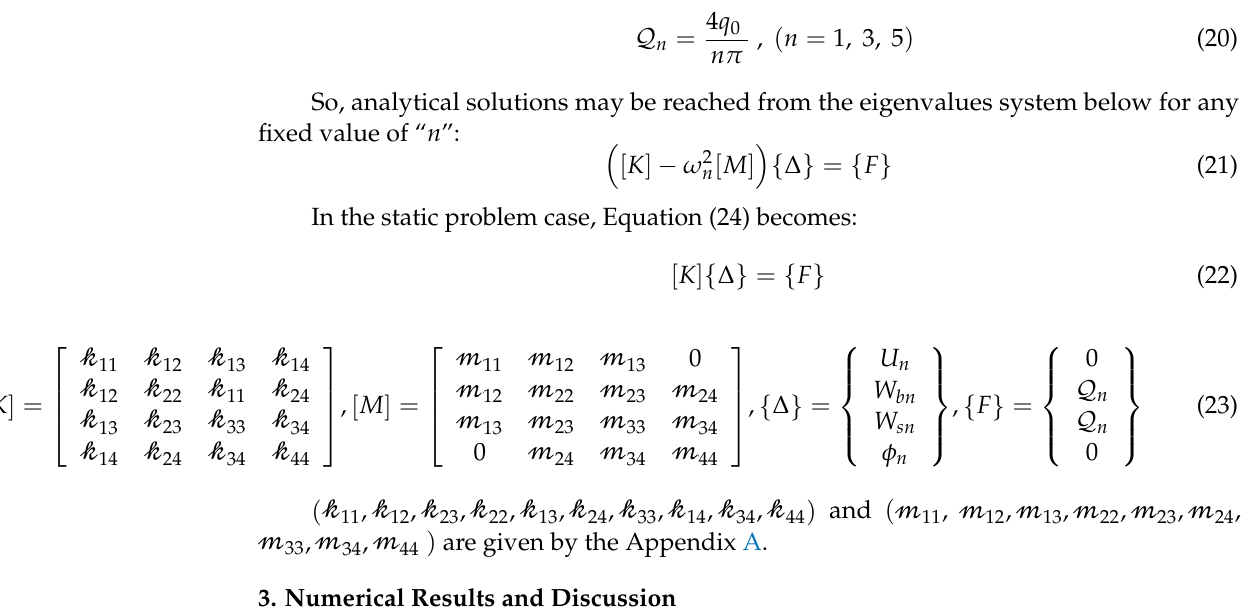
Table 1. Material characteristics of 𝐴𝑙 (cid:2870) 𝑂 (cid:2871) and 𝐴𝑙 [38].